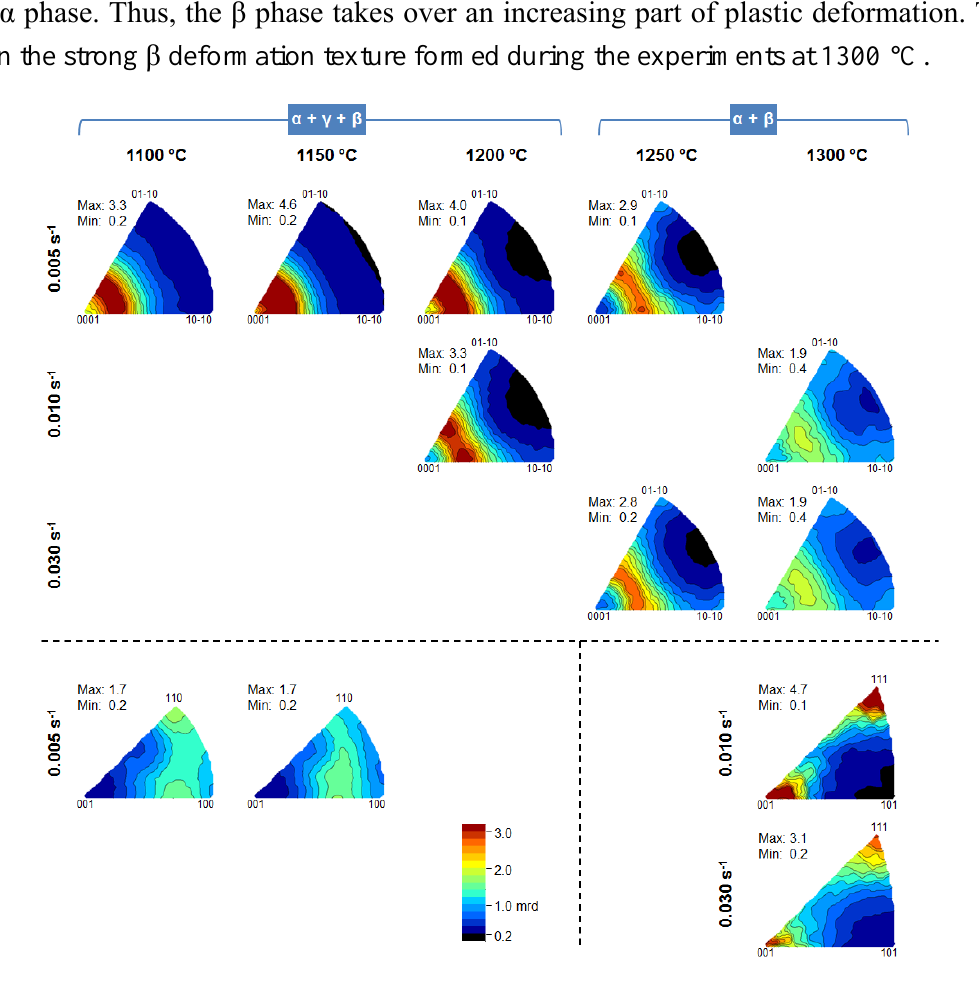
Figure 7. Inverse pole figures in load direction after 30% deformation showing the deformation textures formed during hot compression within different phase fields. Upper figures: the hexagonal α phase. Lower figures: the tetragonal γ phase and the cubic β phase,